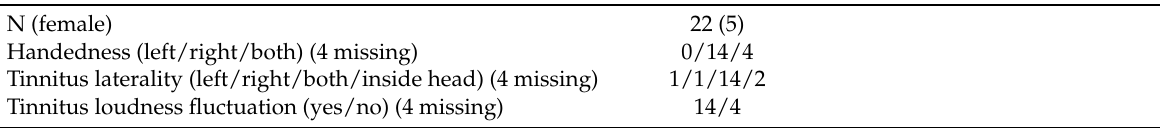
Table 1. Participant